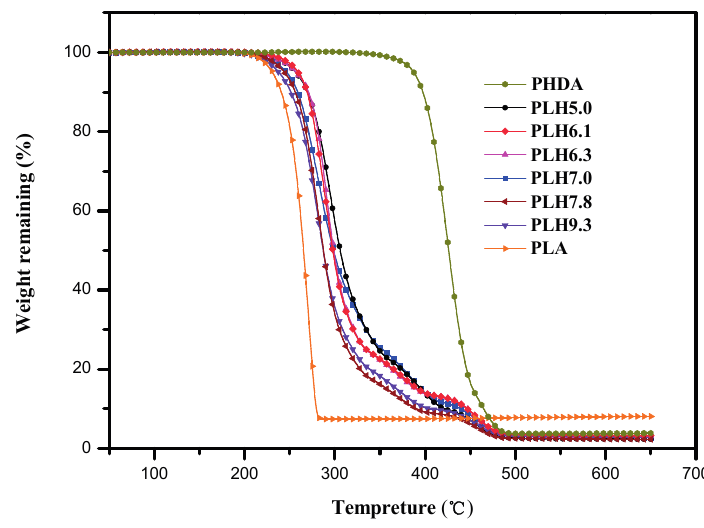
Figure 3. TGA curves of the PLH copolymers under N 2 at a heating rate of 10 °C/min. Weight loss does not take place for all synthesized polymers before 190 °C under N 2